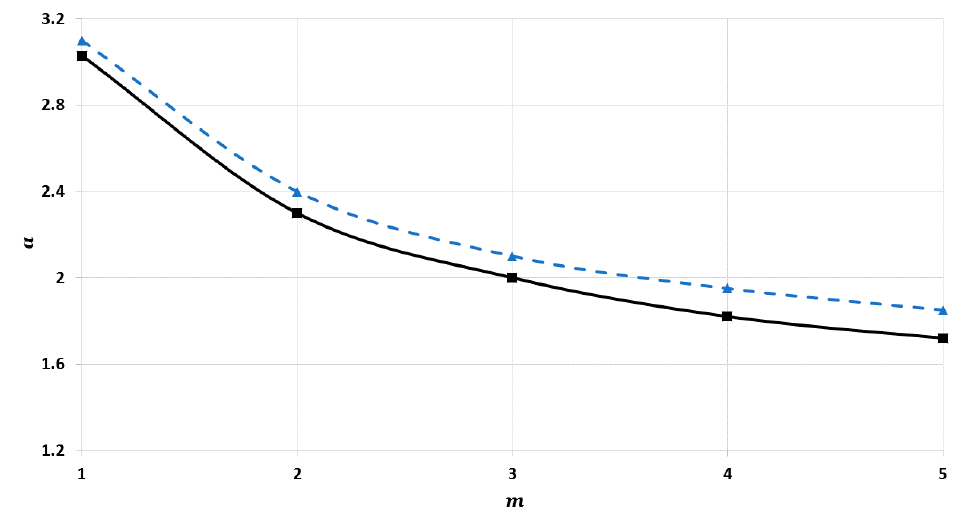
Figure 10. The relation between the values of m and α used to calculate the relative cohesive energies in agreement with the experimental values can be seen: (a) For the Mo nanoparticles (0.686 for n = 2000 atoms [23,24]), as represented by the blue dashed line and triangles, and (b) for the W nanoparticles (0.751 for n = 7000 atoms [23,24]), as represented by the black solid line and squares for a face-centered cubic structure. The values for m = 1 were obtained from previous works [13]. From another perspective, it was also found that the nanoparticles can be stable with a different number of atoms (cid:1866) with the same cohesive energy if the values of (cid:1865) and (cid:2009) of the potential function are changed, as seen in Figure 11 (shows the relation between (cid:1866) and (cid:1865) for different values of (cid:2009) ) and Figure 12 (shows the relation between (cid:1866) and (cid:2009) for different values of (cid:1865) ). Both figures show that the nanoparticles can be stabilized with a larger number of atoms having the same cohesive